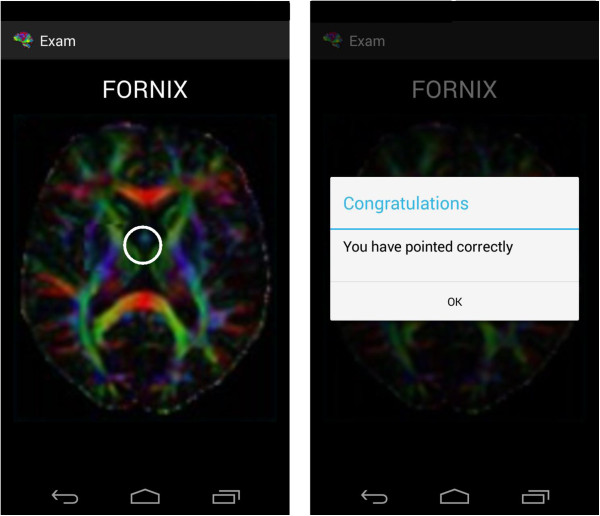
Examination Type 2.